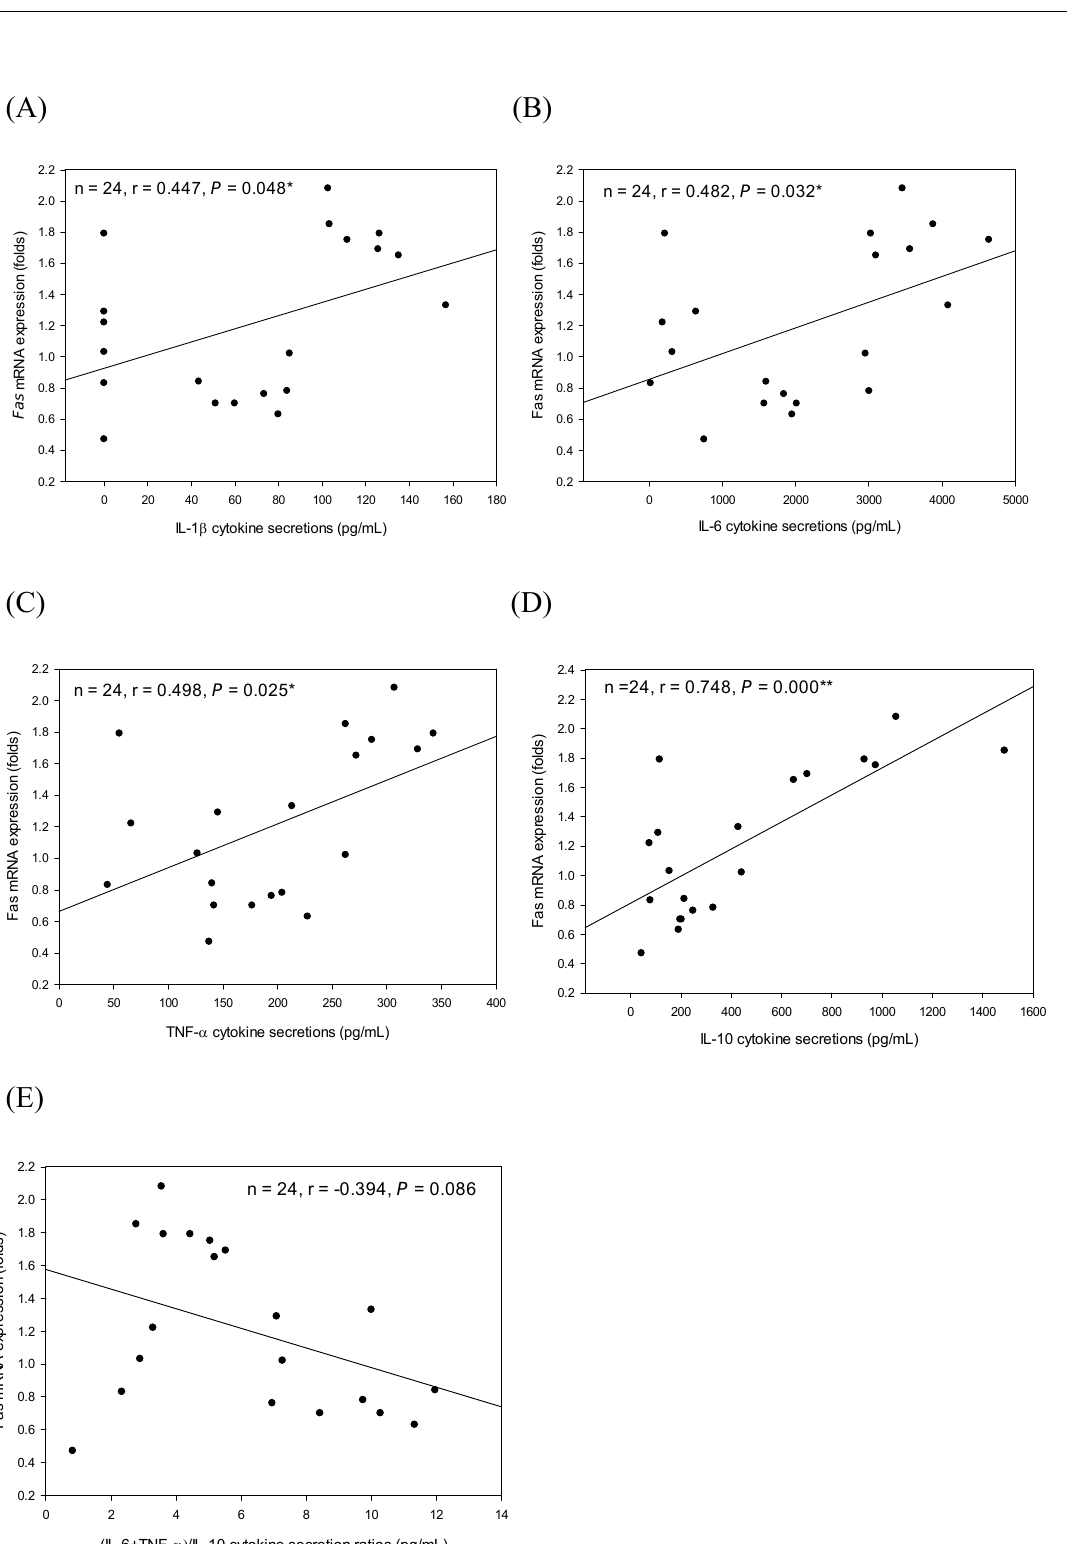
Figure 6. Correlations between IL-1 β ( A ), IL-6 ( B ), TNF- α ( C ), IL-10 ( D ), as well as (IL-6+TNF- α )/IL-10 ( E ) cytokine secretion profiles in macrophage conditioned media cultured with GSF3 (MGSF3) and Fas mRNA expression amounts in the corresponding treated PC-3 cells. The correlation was expressed by the Pearson product-moment correlation coefficient (r). The correlation is considered statistically different if p < 0.05. *, p < 0.05; **, p <